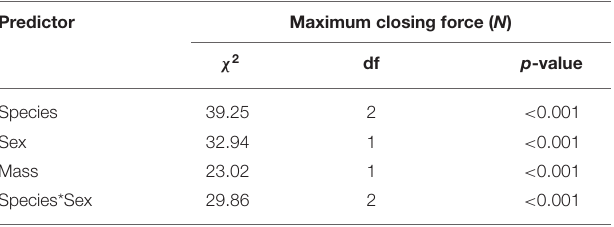
TABLE 2 | Model terms for all factors from a linear mixed effects model used to determine differences in maximum closing force ( N ) with regards to fixed factors “species,” “sex,” and “mass,” using a Type 3 Anova and χ 2 to report the effect size of a factor on the dependent variable.